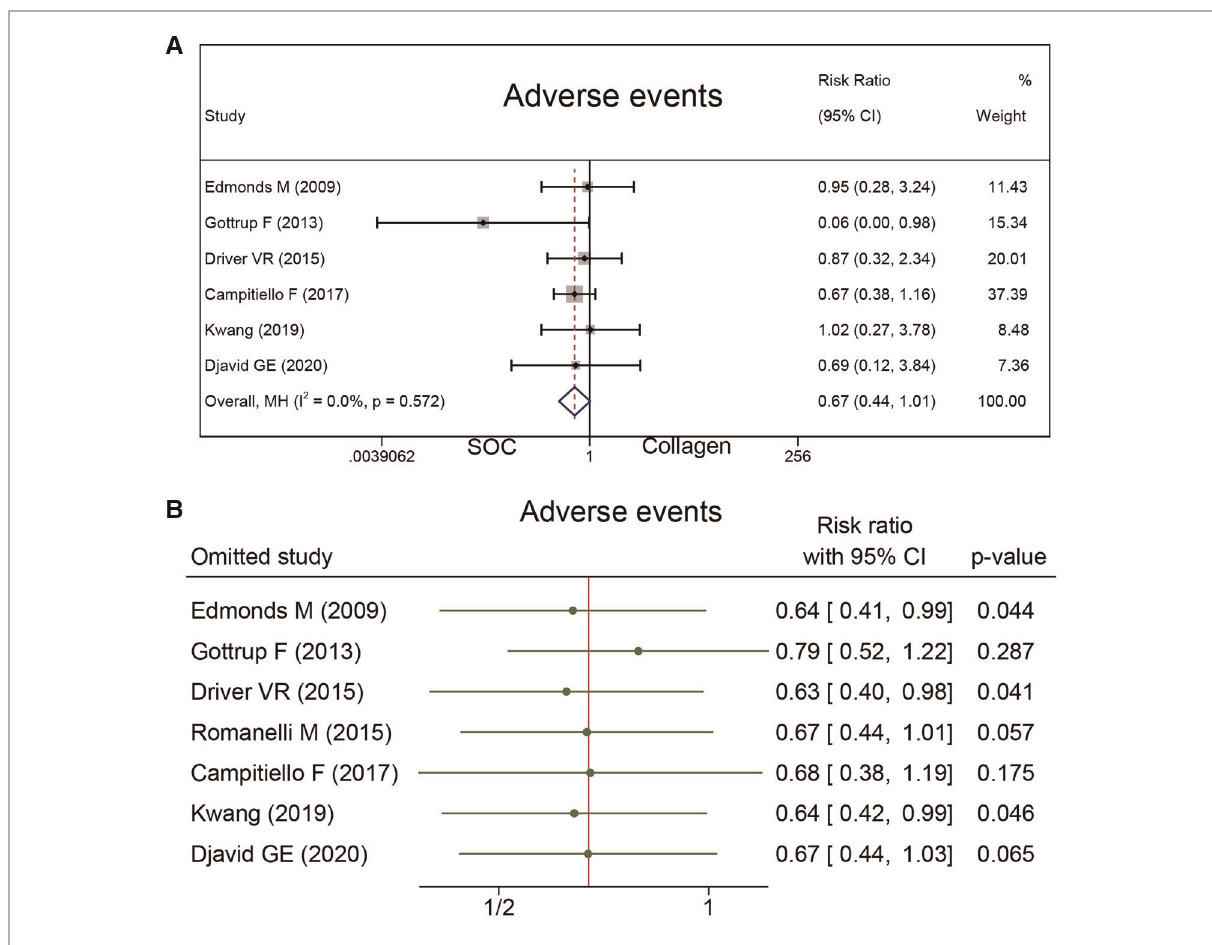
FIGURE 7 Adverse events: ( A ) the pooled result; ( B ) sensitivity